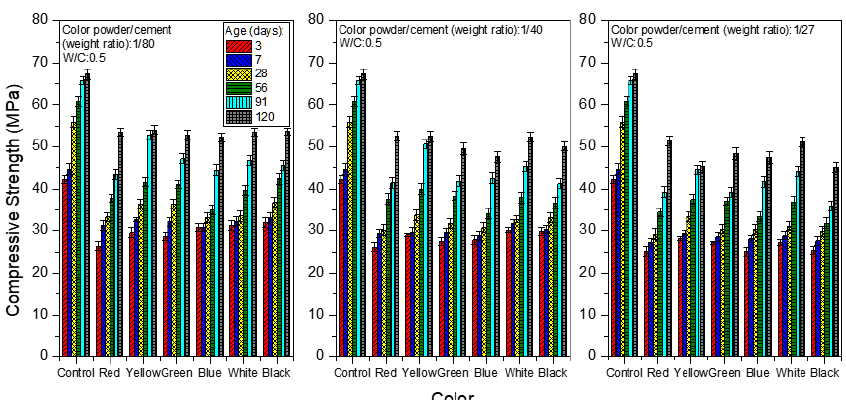
Figure 6. Compressive strength of colored mortar at W/C = 0.5 and under saturated limewater curing when weight ratios of color powder/cement at 1:80, 1:40, and 1:27 are added.